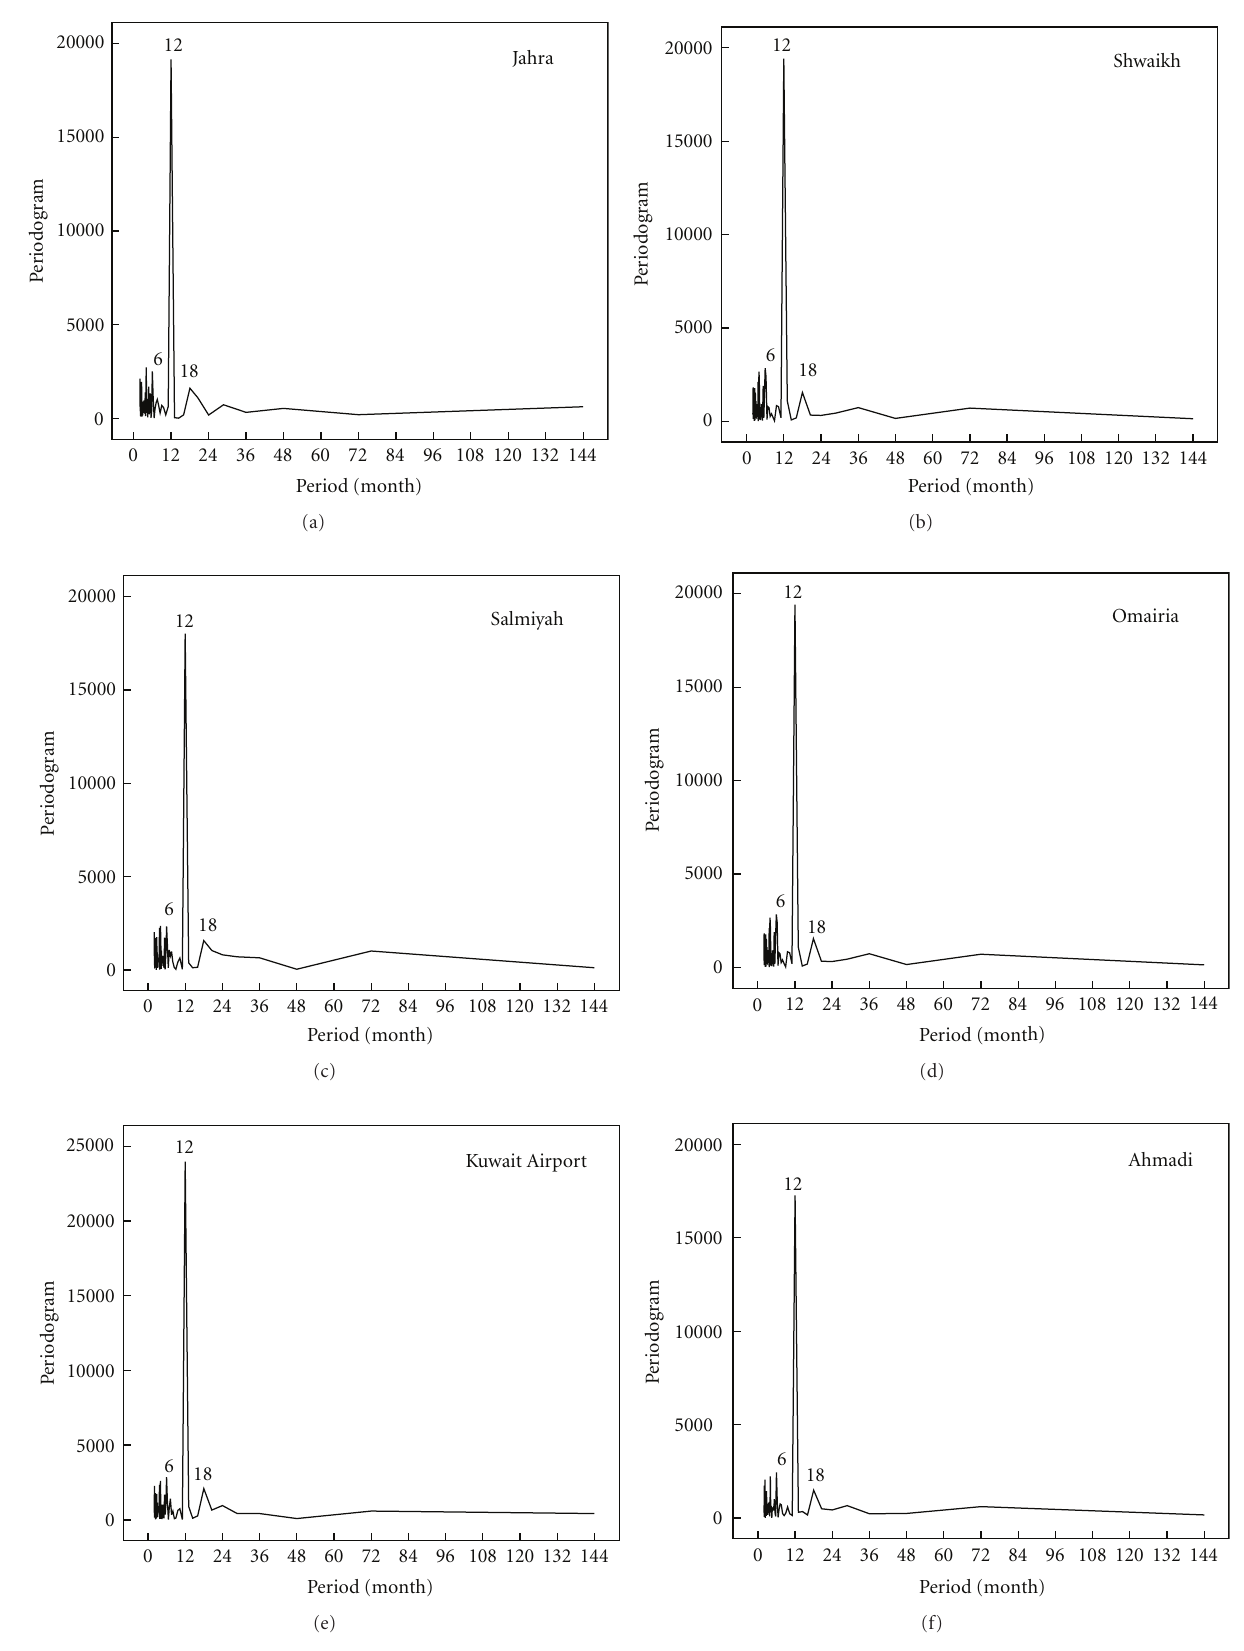
Figure 3: Periodograms for the monthly total rainfall data obtained from the weather stations in urban areas for the time duration from January 1994 to December